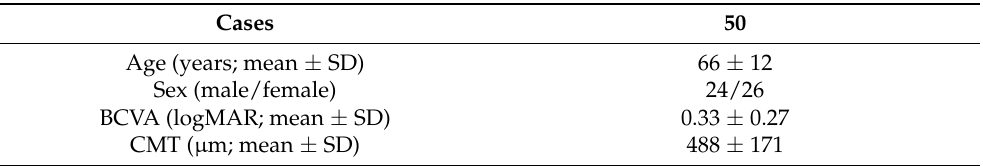
Table 1. Baseline